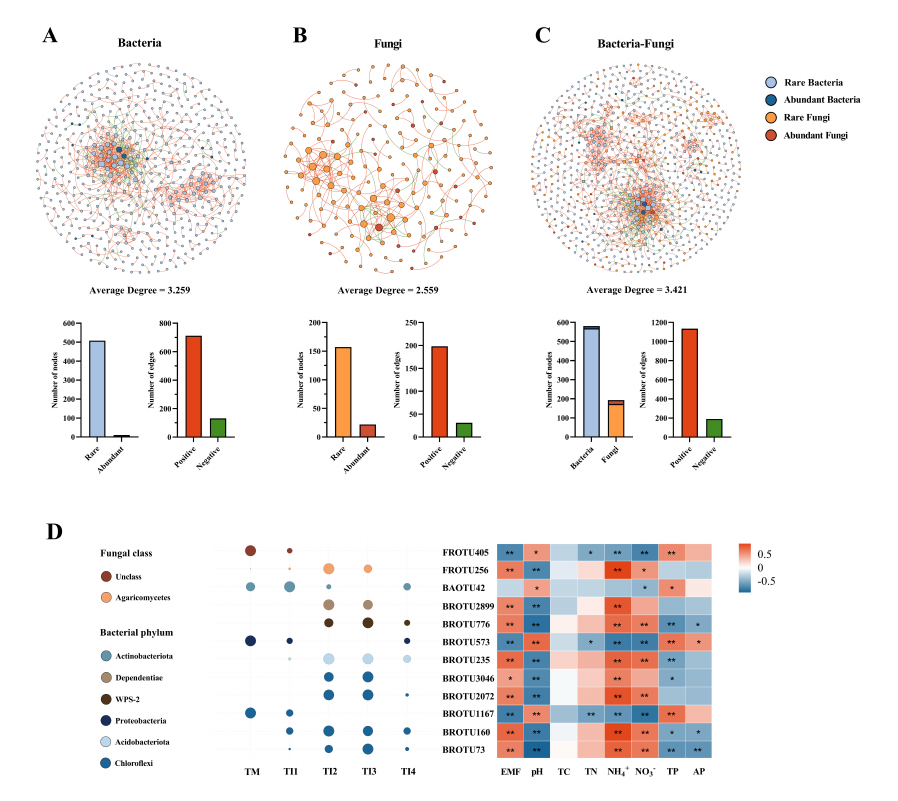
Figure 6. Keystone OTUs and their relationship with ecosystem multifunctionality and soil properties. The co-occurrence networks, average degree, number of nodes, and number of edges in ( A ) bacterial; ( B ) fungal; ( C ) bacterial–fungal communities; and ( D ) Bubble plot showing the relative abundance and taxonomy of the keystone OTUs in each treatment. Spearman correlations between keystone OTUs and ecosystem multifunctionality and soil properties are shown in the heatmap. Node size is proportional to the number of connections (degree), and the keystone OTUs are represented by square nodes. The red edges indicate positive interactions between two nodes, and green edges indicate negative interactions. The bubble size represents the relative abundance. Treatments include tea-plant monoculture (TM), tea intercropping with soybean (TI1), tea intercropping with soybean—milk vetch (TI2), tea intercropping with soybean—red clover (TI3), and tea intercropping with soybean—smooth vetch (TI4). The BROTU, BAOTU, and FROTU represent rare bacterial, abundant bacterial, and rare fungal OTUs, respectively. The colors in the heat map represent Pearson’s correlation coefficients, with red representing positive and blue representing negative. Significant correlations are labeled as follows: ** p < 0.01; * p <